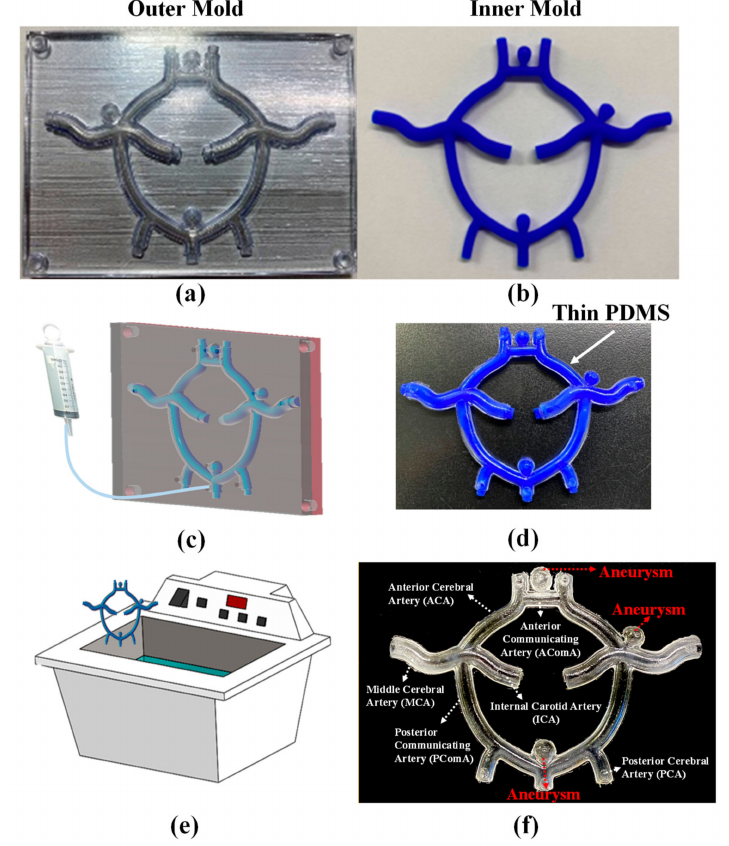
Figure 2. ( a ) The two outer (clamshell) molds fabricated using a commercial 3D printer (Objet30 Dental Prime, Stratasys) with a biocompatible material (MED 610, Stratasys); ( b ) the inner wax mold fabricated using a commercial 3D printer (Projet 3500 CPX Max, 3D Systems) with a wax material (Visijet Hi-Cast, 3D Systems); ( c ) PDMS was slowly injected into the gap between the molds until the gap was completely filled; ( d ) the PDMS casting (with inner mold still intact) following removal of the outer molds; ( e ) dissolution of the inner wax mold was facilitated using ultrasonication, as reported previously [23]; ( f ) the resulting Circle of Willis with major corresponding